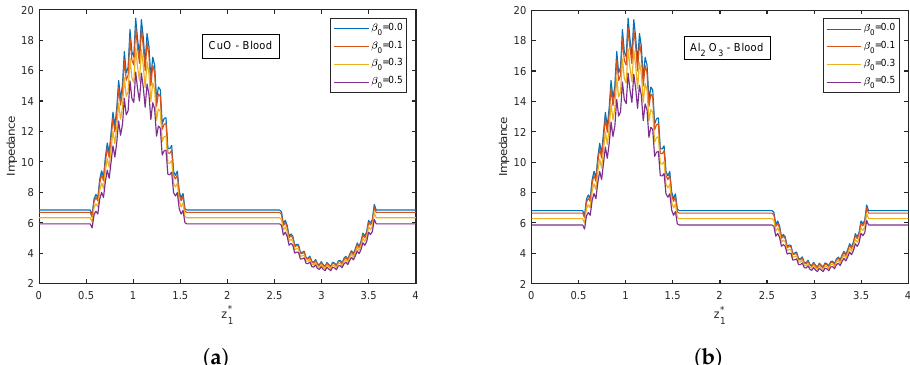
Figure 21. Impedance profiles of viscosity parameter β 0 for ( a ) CuO-nanoparticles, ( b ) Al 2 O 3 - nanoparticles at t ∗ = 1.2. 1